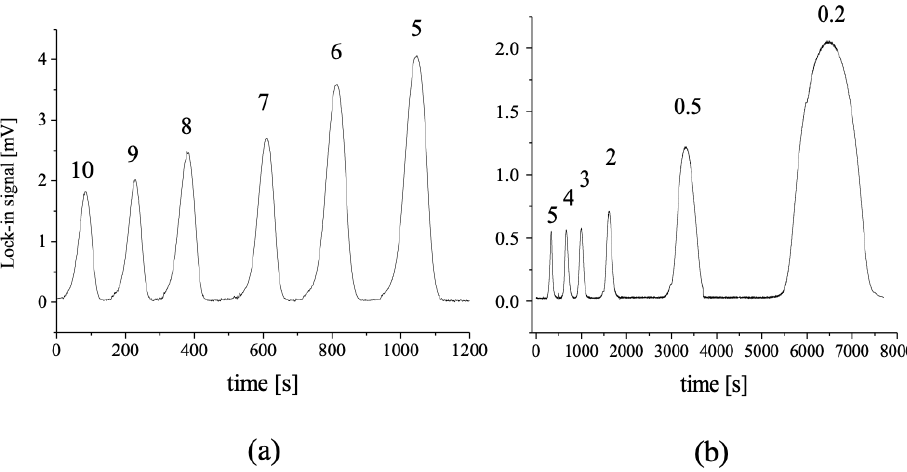
Figure 6. Dependence of the TLM signal on the carrier flow rate (indicated on top of the peaks in µ L/min) at 5 µ L injection volume from 5 mM NH 4 Cl ( a ) and 0.5 mM NH 4 Cl ( b ). Lower concentration was chosen at lower flow rates for the prevention of signal saturation.